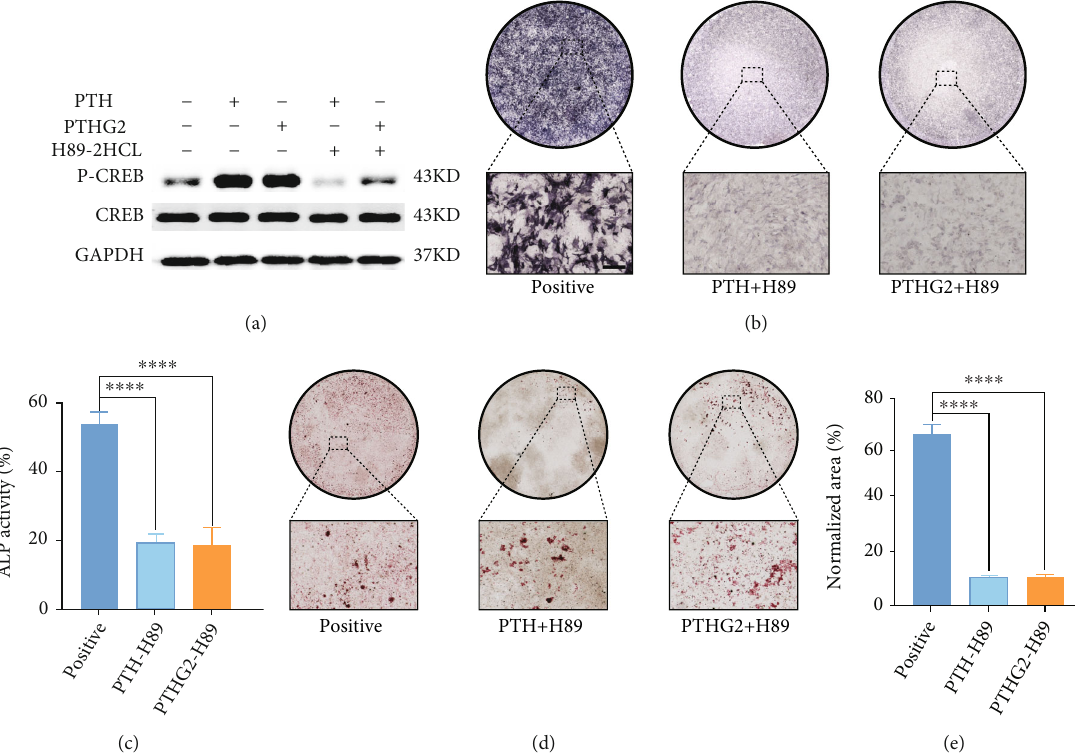
Figure 5: PTHG2 stimulates osteogenic di ff erentiation of BMSCs through cAMP-PKA signaling. (a) Densitometry analysis of P-CREB protein levels. (b) ALP staining and (c) quanti fi cation after H89-2HCL pretreatment. (d) Oil red O staining and (e) quantity after H89- 2HCL pretreatment. Scale bar, 30 μ m ( n = 3 ); ∗ p < 0 : 05 , ∗∗ p < 0 : 01 , ∗∗∗ p < 0 : 001 , ∗∗∗∗ p < 0 : 001